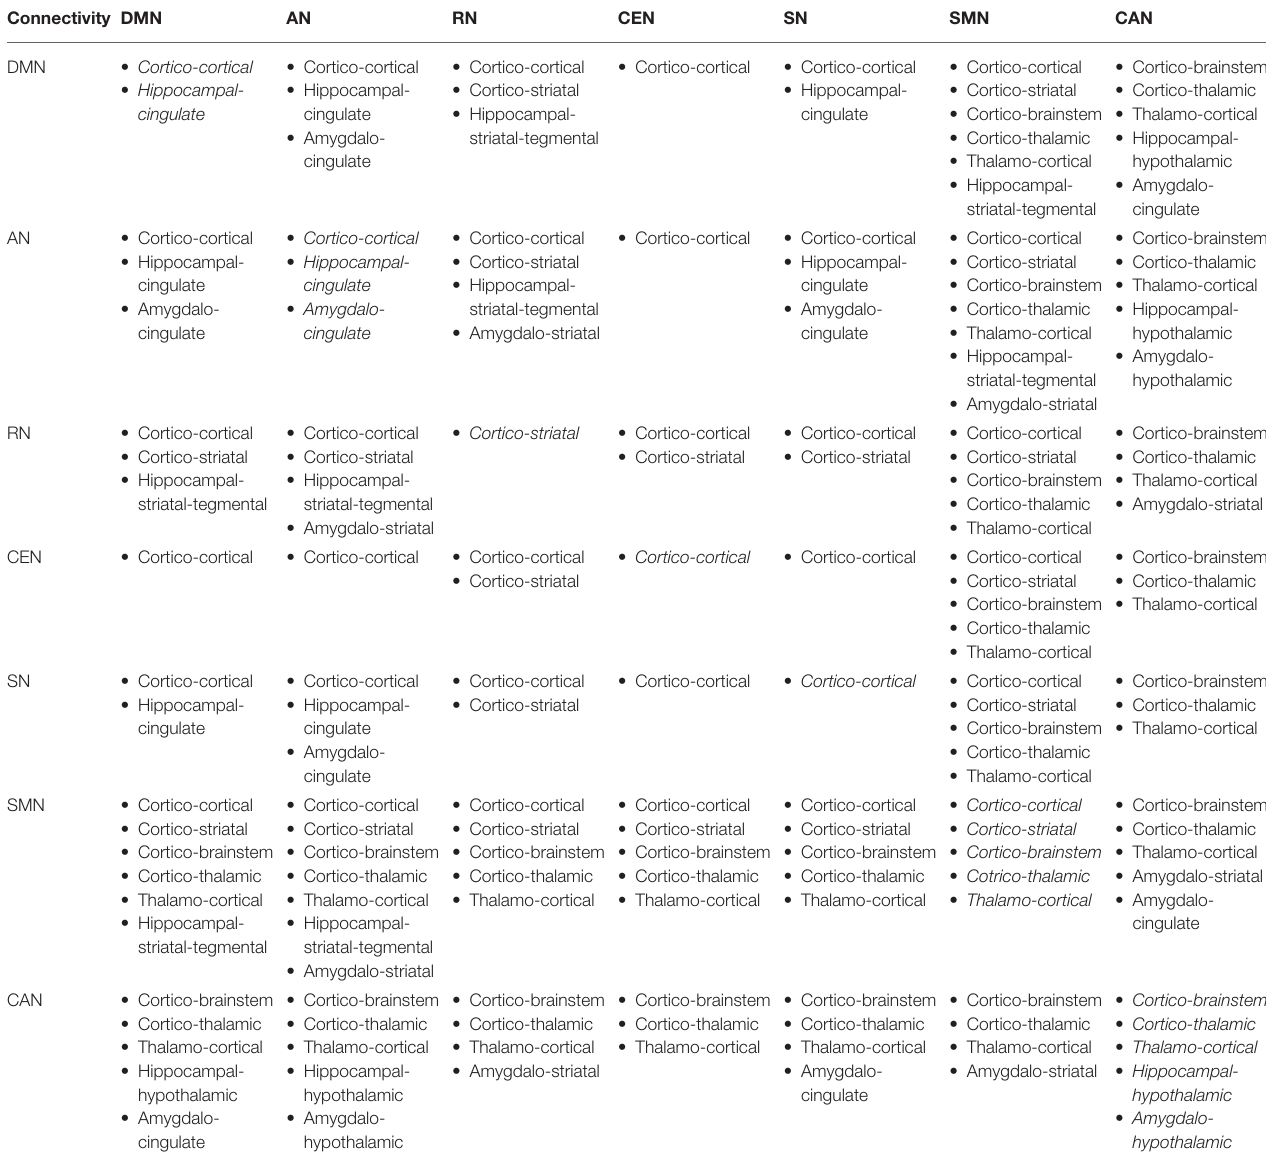
TABLE 2B | Proposed anatomical white matter substrate for glutamate-mediated within- and between-network connectivity. Connectivity DMN AN RN CEN SN SMN